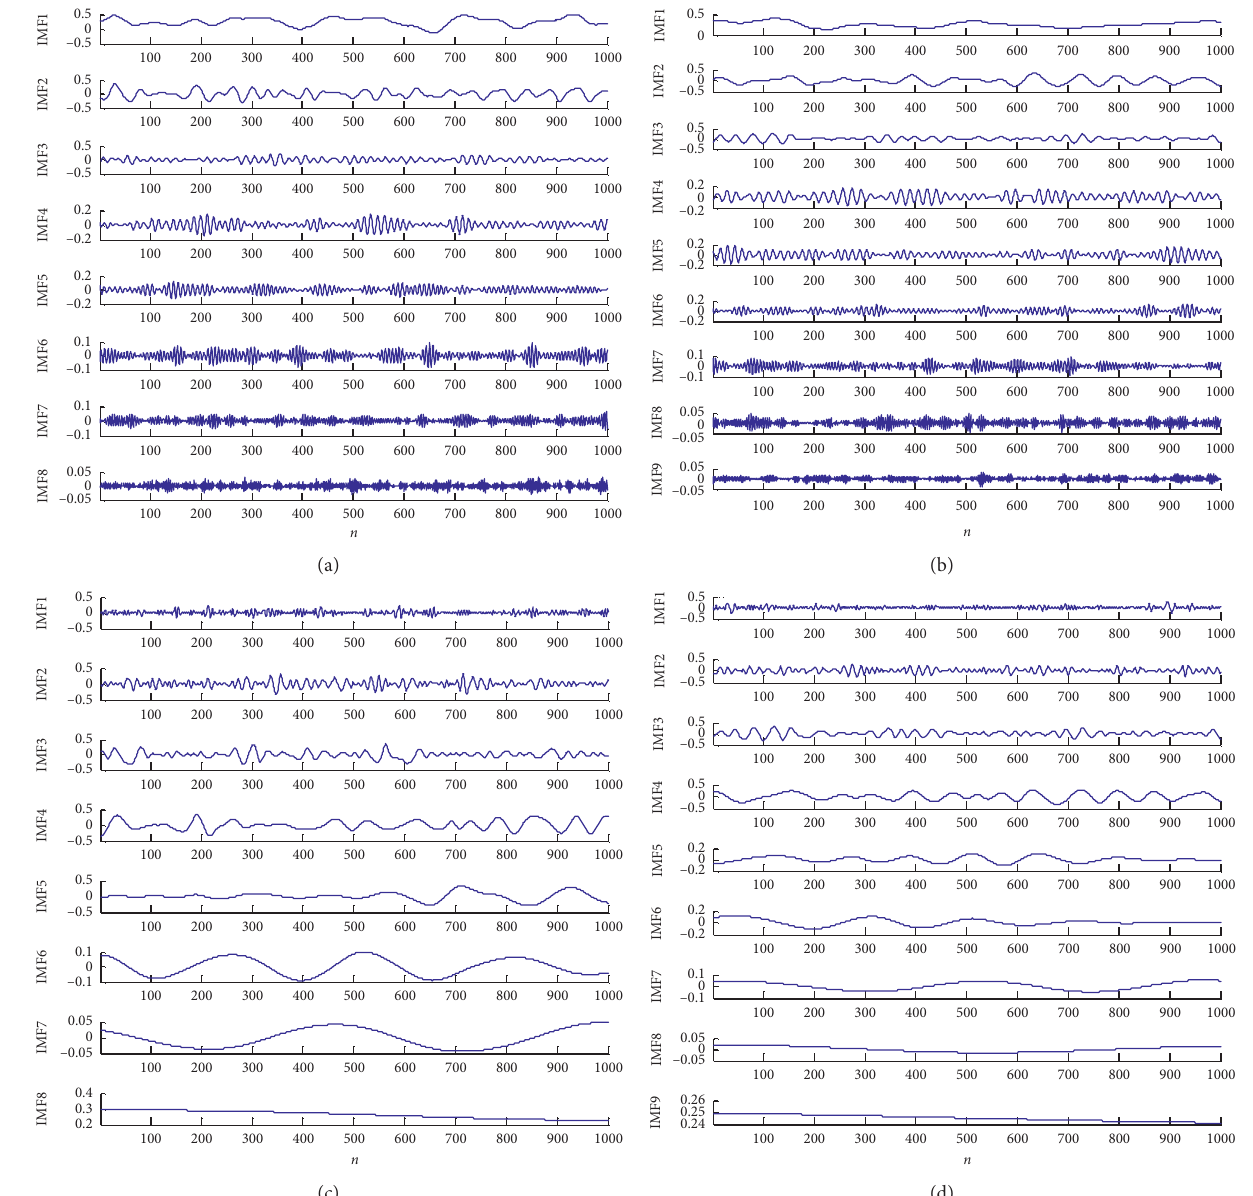
Figure 8: (a) VMD decomposition results of data set A; (b) VMD decomposition results of data set B; (c) EMD decomposition results of data set A; (d) EMD decomposition results of data set